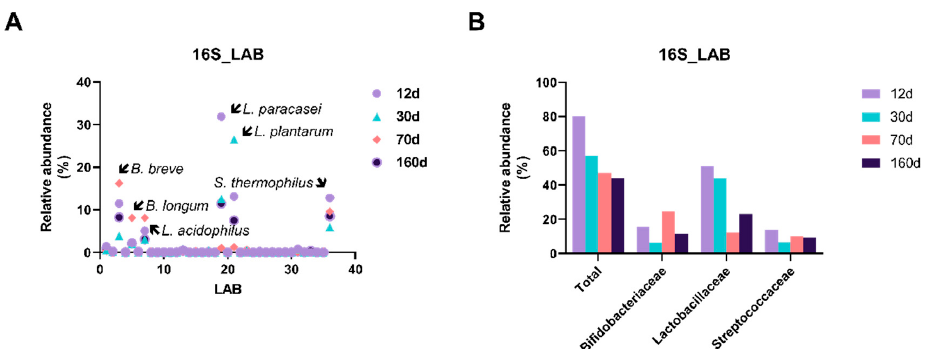
Figure 6. Relative abundance (%) plots of lactic acid bacteria on the surface of dry-aged beef with respect to the aging periods. A total of 36 lactic acid bacterial species ( A ) were detected, including families of Bifidobacteriaceae, Lactobacillaceae , and Streptococcaceae ( B ). Major species with high relative abundance are indicated in ( A ).